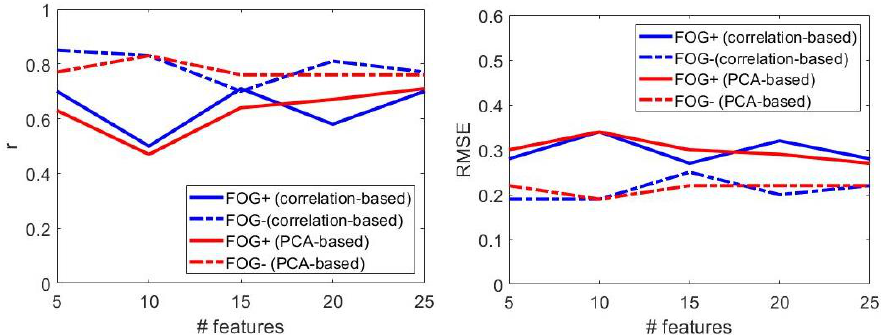
Figure 9. The effect of freezing of gait on the regression model performance, in terms of correlation co- efficient ( left ) and root mean square error ( right ). Performance refers to patients under dopaminergic therapy. FOG+: patients with freezing of gait; FOG − : patients without freezing of